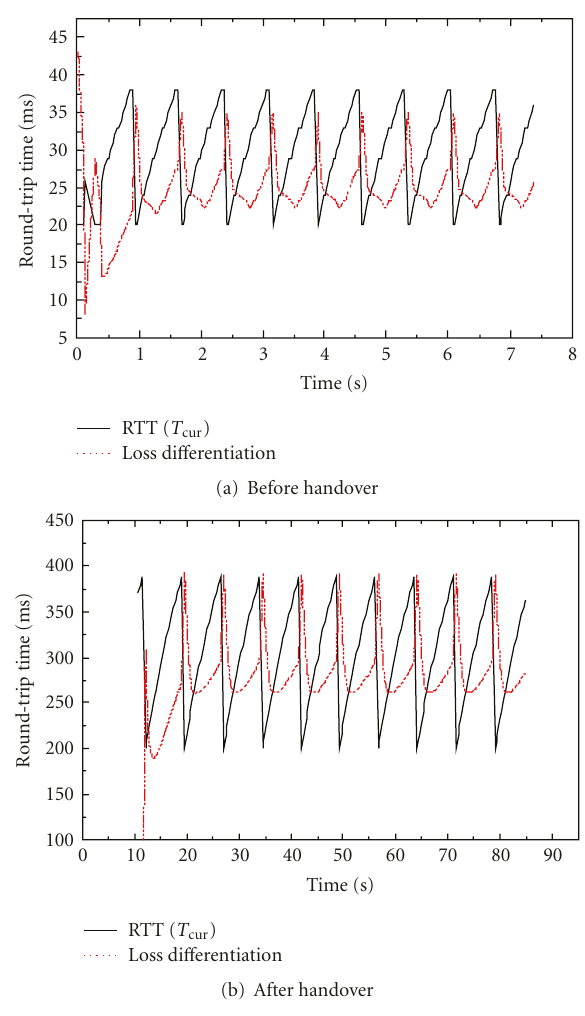
Figure 3: Loss di ff erentiation on vertical handover from WLAN to 3G